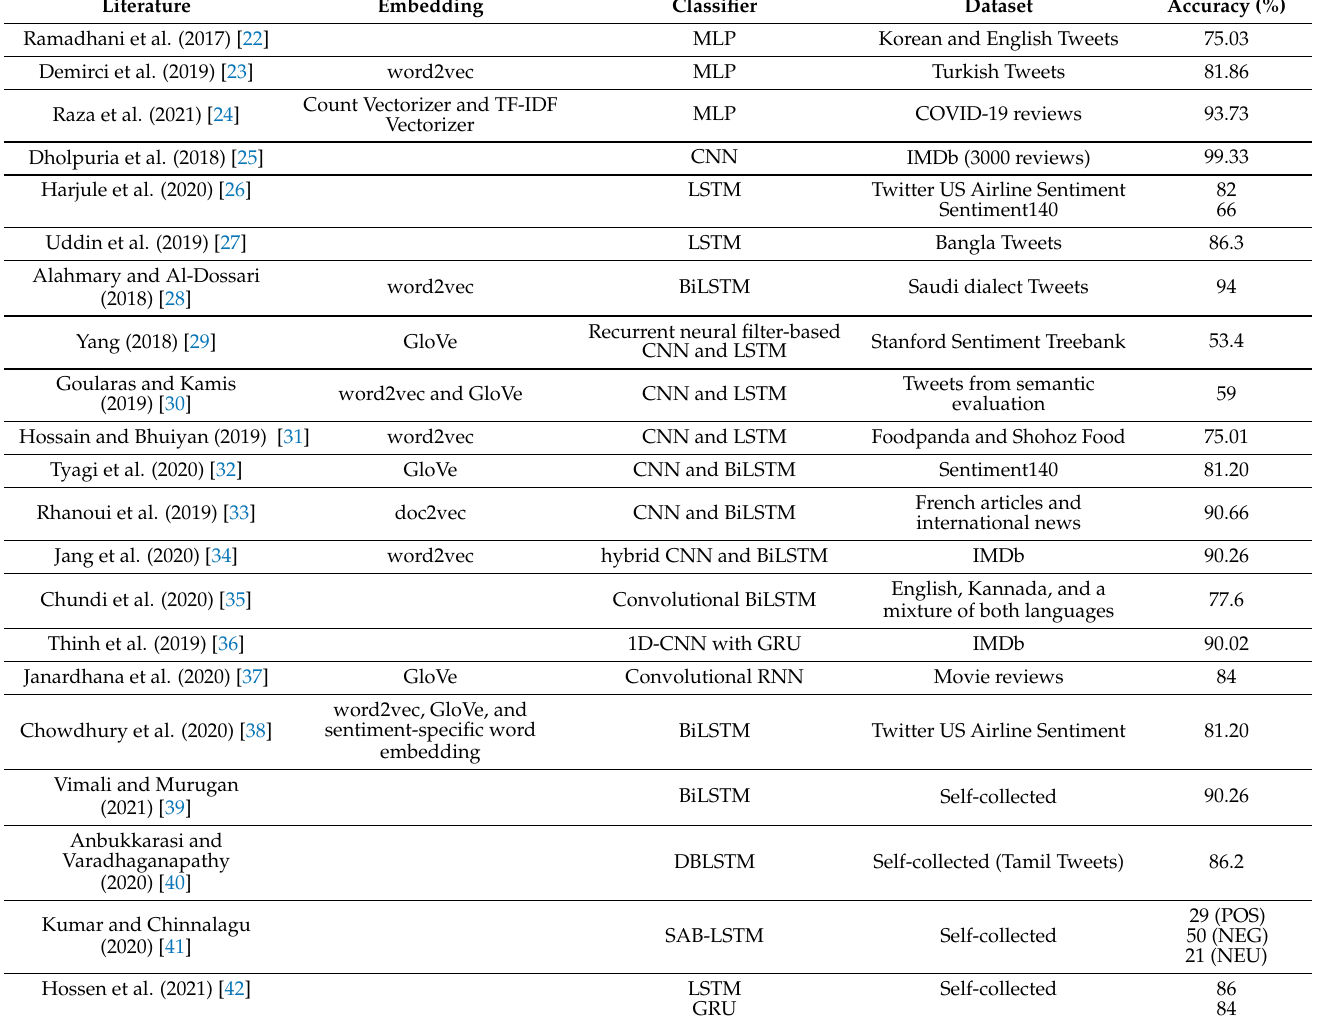
Table 2. Summary of deep learning